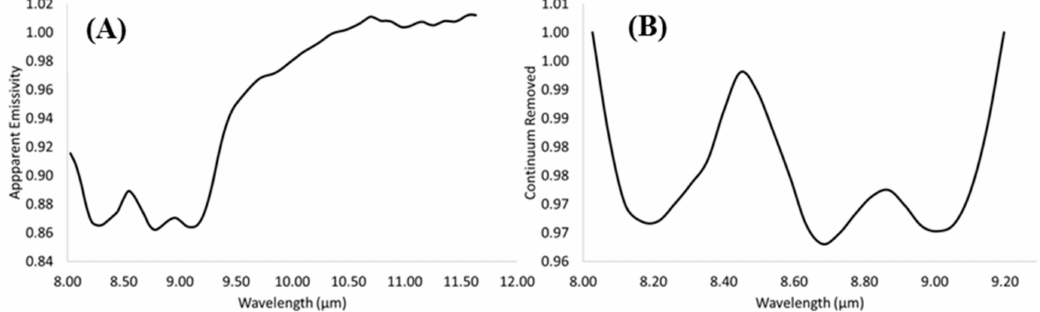
Figure 2. ( A ) Apparent emissivity spectrum of a selected image pixel. ( B ) Continuum-removed (CR) function on the spectrum in the range 8.12–9.29 µ m. This pixel was classified as quartz using the index: CR λ = 8.26 µ m < 0.993 and CR λ = 9.12 µ m < 0.995 from